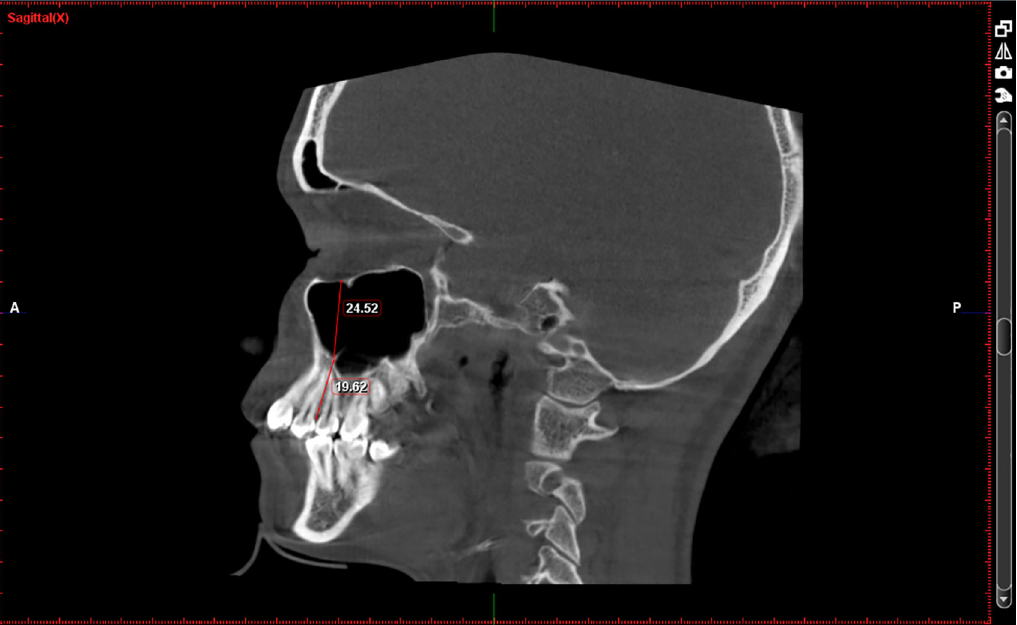
Figure 1. Height of the maxillary sinus (at location PM1-PM2) and Basal bone height (between